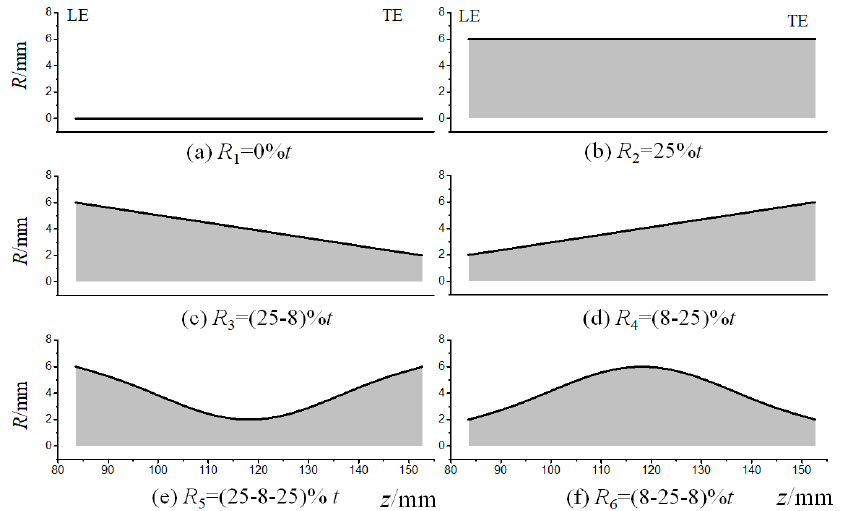
Figure 7. Radius distribution of six different fillet structures.